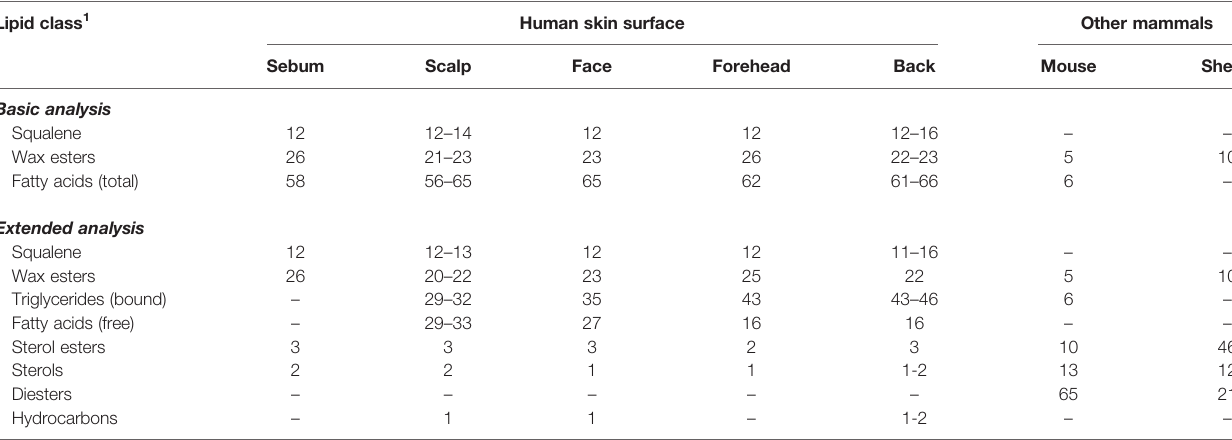
TABLE 1 | Lipid class composition of various skin sites (% total